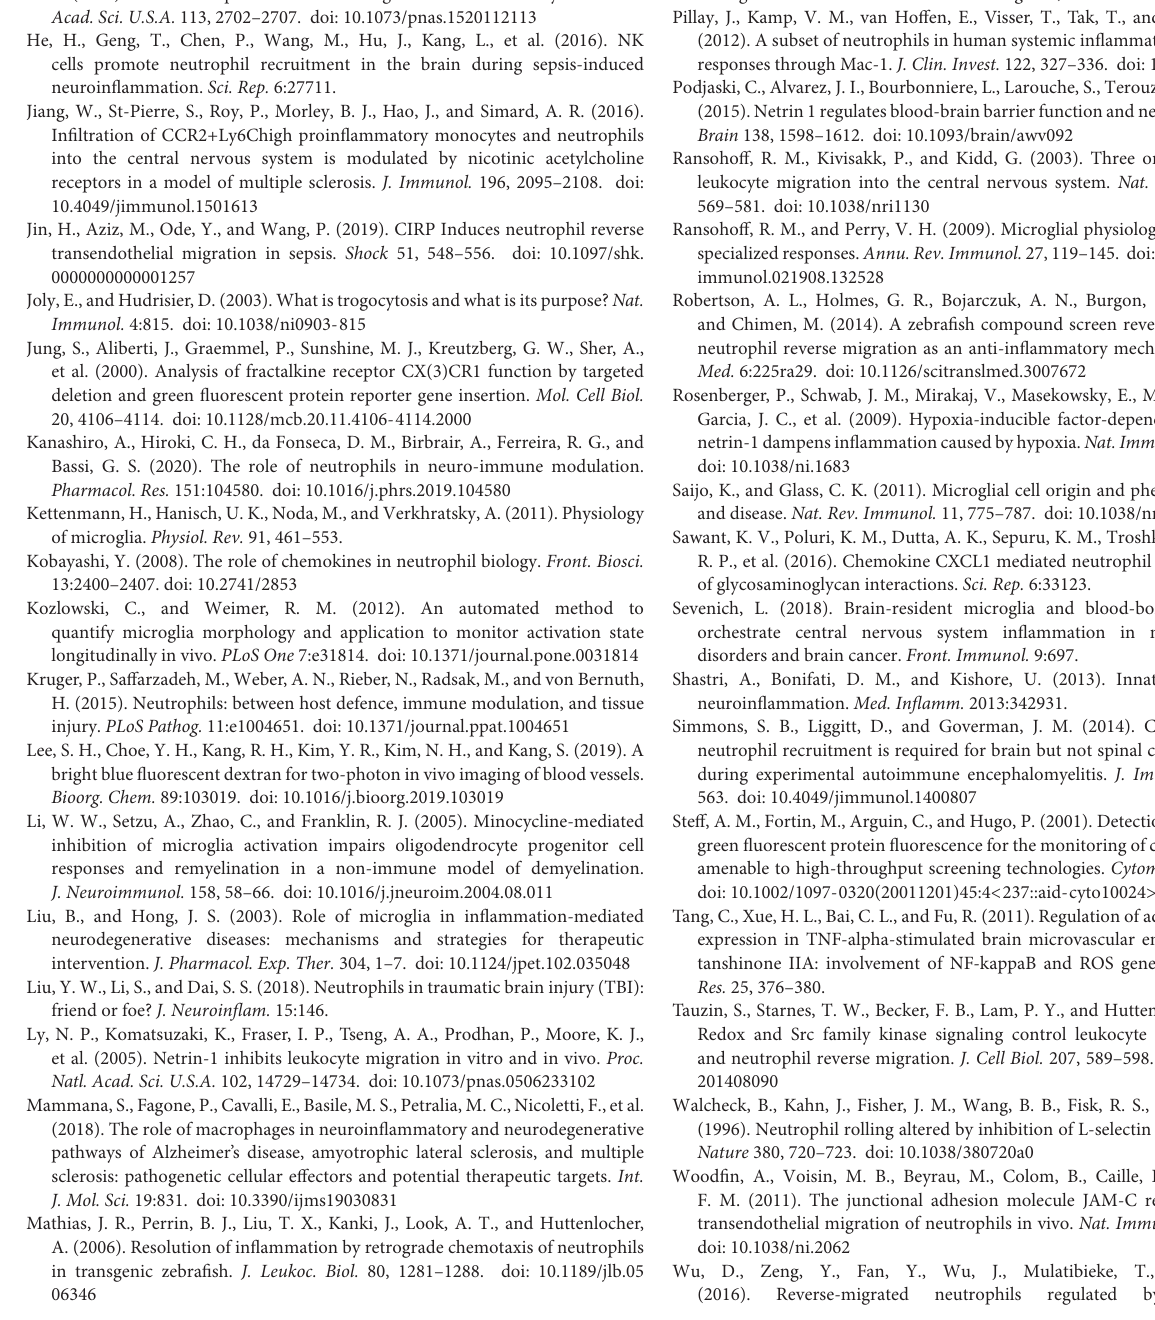
regulated by are